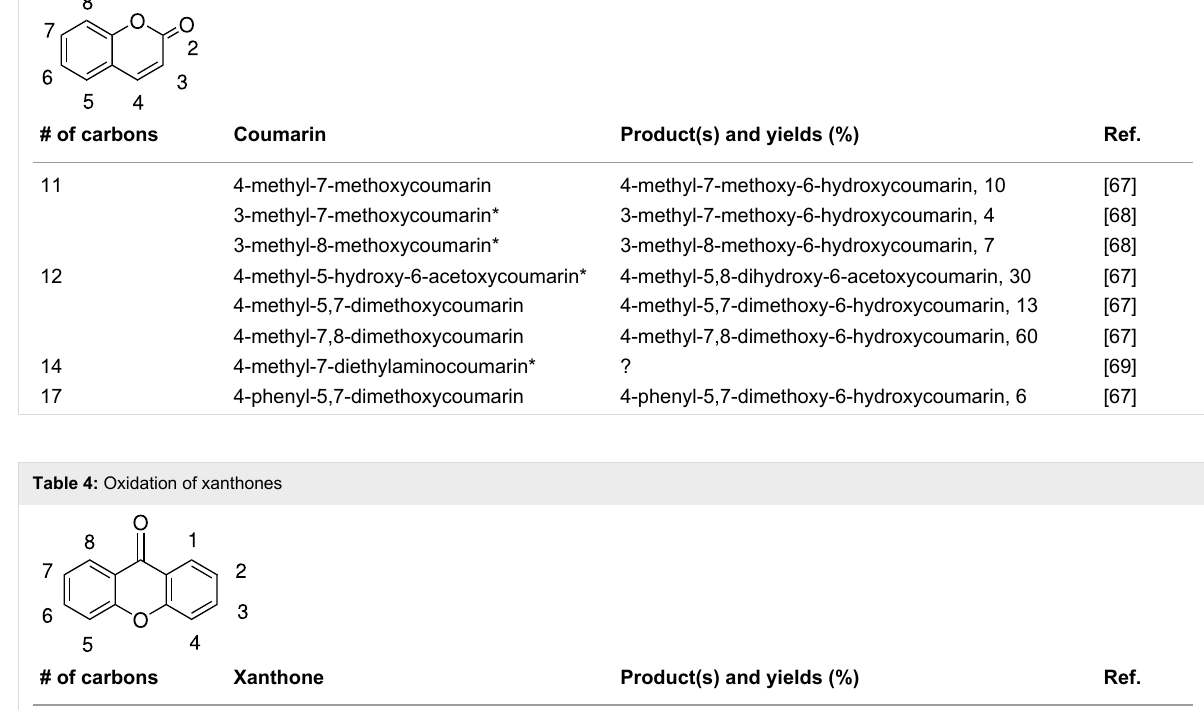
Table 3: Oxidation of coumarins